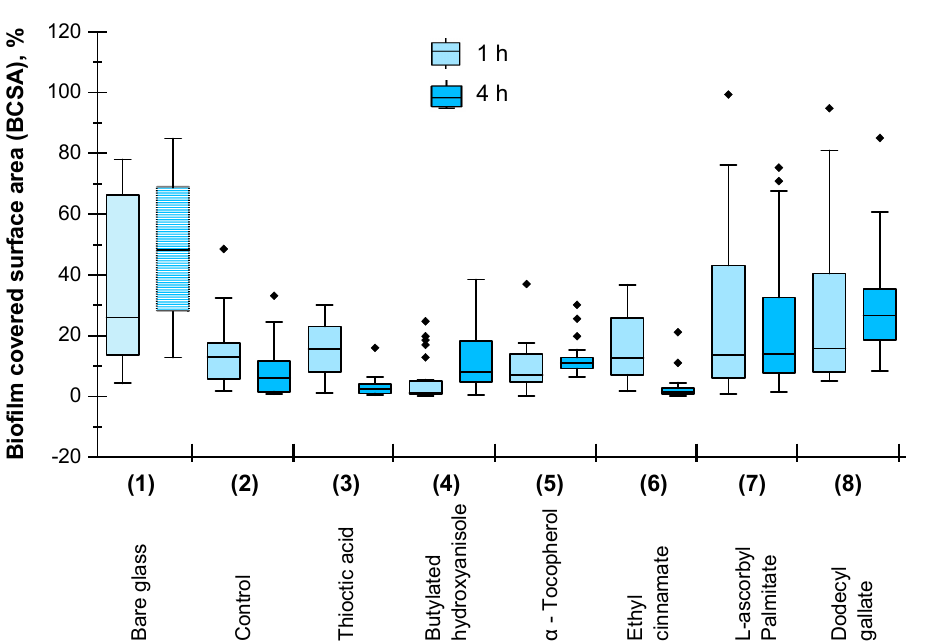
Figure 2. Biofilm covered surface area (BCSA), % on bare glass (Sample 1); control, glass with siloxane composite coating without antioxidants (Sample 2) or containing different antioxidants: Thioctic acid (Sample 3); Butylated hydroxyanisole (Sample 4); α -Tocopherol (Sample 5); Ehthyle cinnamate (Sample 6); L-ascorbile palmitate (Sample 7); Dodecyl gallate (Sample 8).